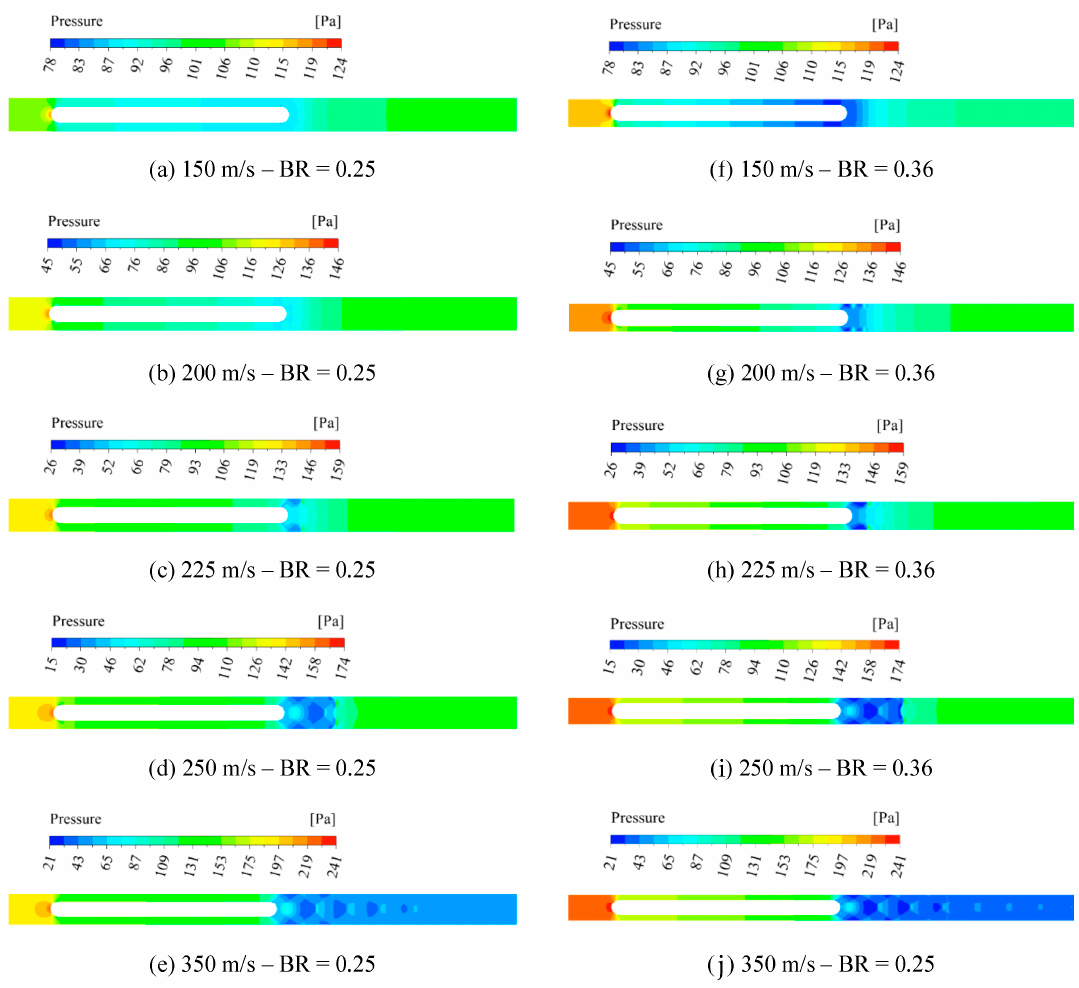
Figure 8. Pressure contours for selected pod speeds with P tube = 101.325 Pa, L pod = 43 m, and ( a – e ) for BR = 0.25, ( f – j ) for BR = 0.36. Contour levels are fixed for each pod speed.